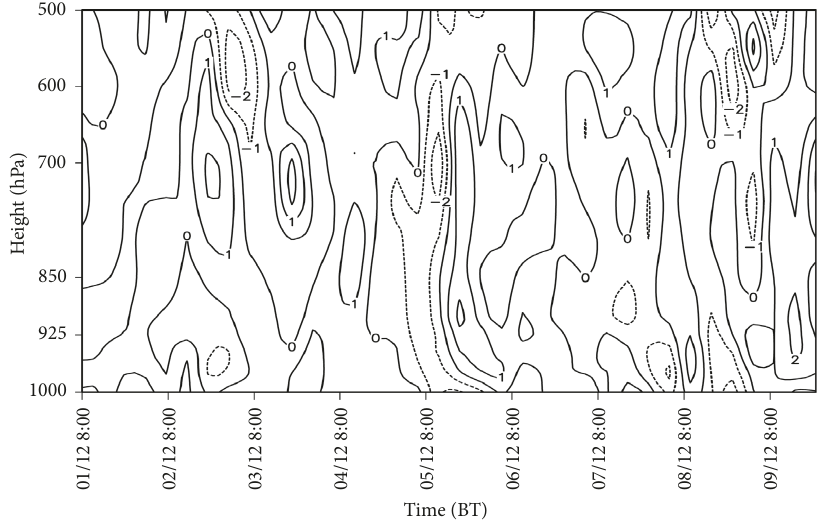
Figure 9: Time-height profile of divergence at the Sheyang site from 1 to 9 December 2013. Unit: 10